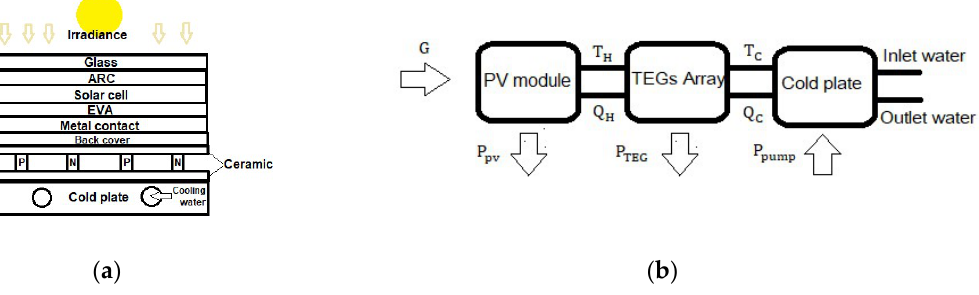
Figure 1. ( a ) Standard PV TEG system configuration, ( b )Power flow digram .